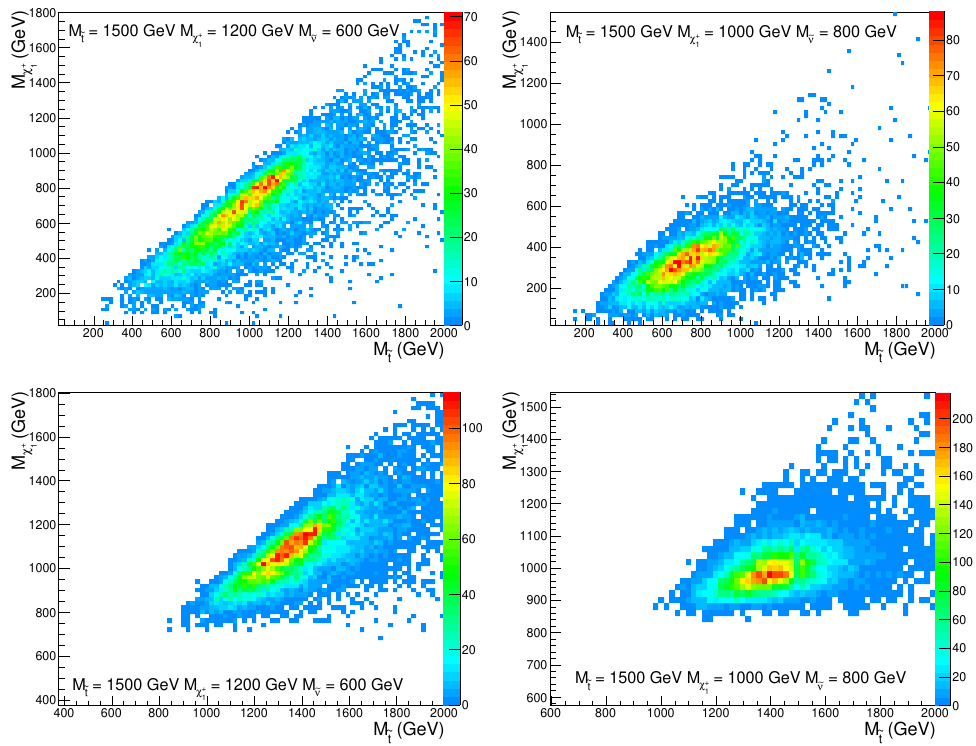
Figure 9 . Reconstructed signal distributions assuming zero M ˜ ν for generated M ˜t = 1500 GeV, M = 1200 GeV, M ˜ ν = 600 GeV (top left) and M ˜t = 1500 GeV, M x + 1 (top